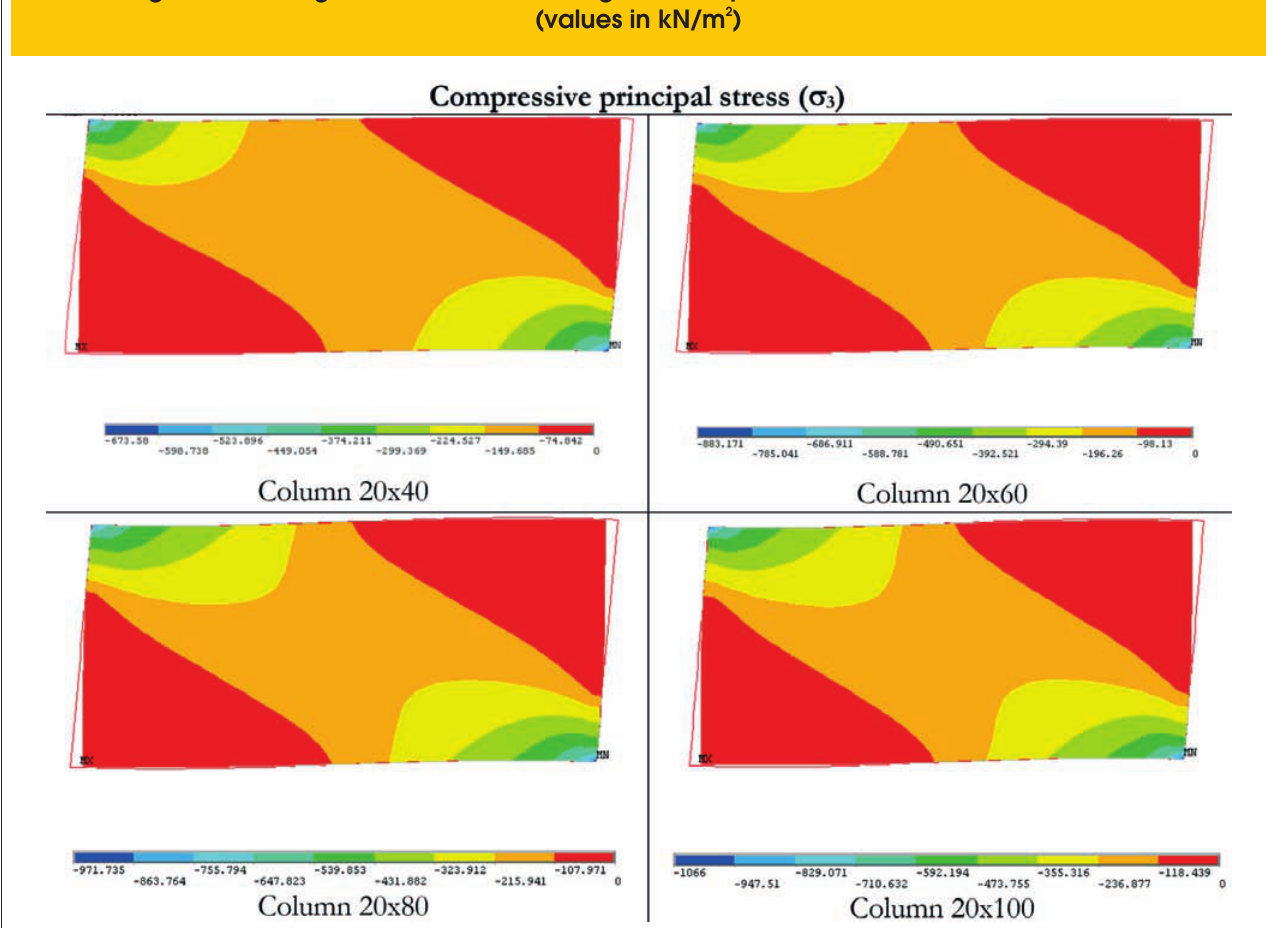
Figure 6 – Acting stresses related to diagonal compression in infill walls – FEM models